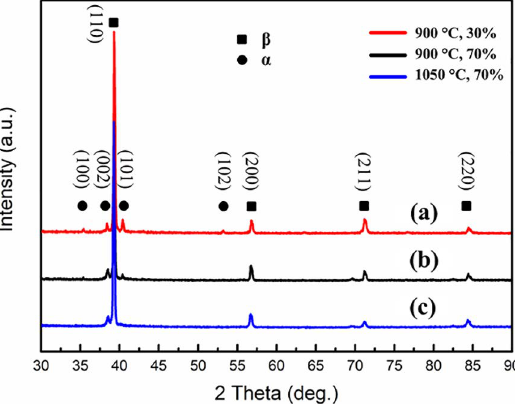
Figure 5. XRD patterns of deformed PM Ti-5553 alloy subjected to various temperatures and deformation degrees at 1 s -1 : (a) 900 °C, 30%; (b)900 °C, 70%; and (c) 1050 °C,